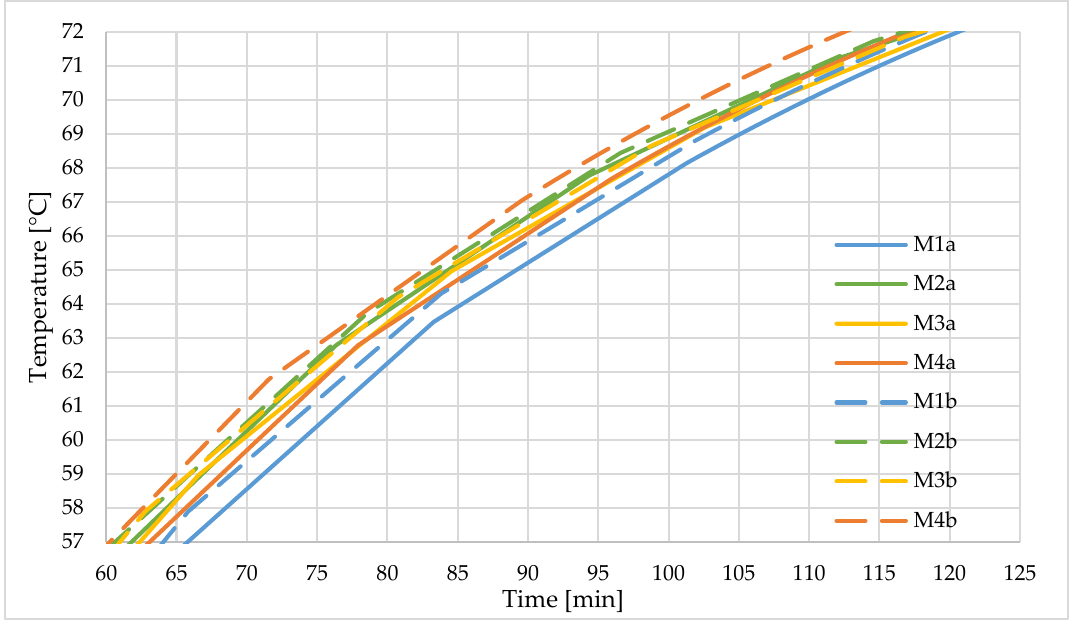
Figure 9. Temperature over time at the front of the tube in Models 1 – 4 for the working fluid velocity of 1 m/s (a), and 4 m/s (b).